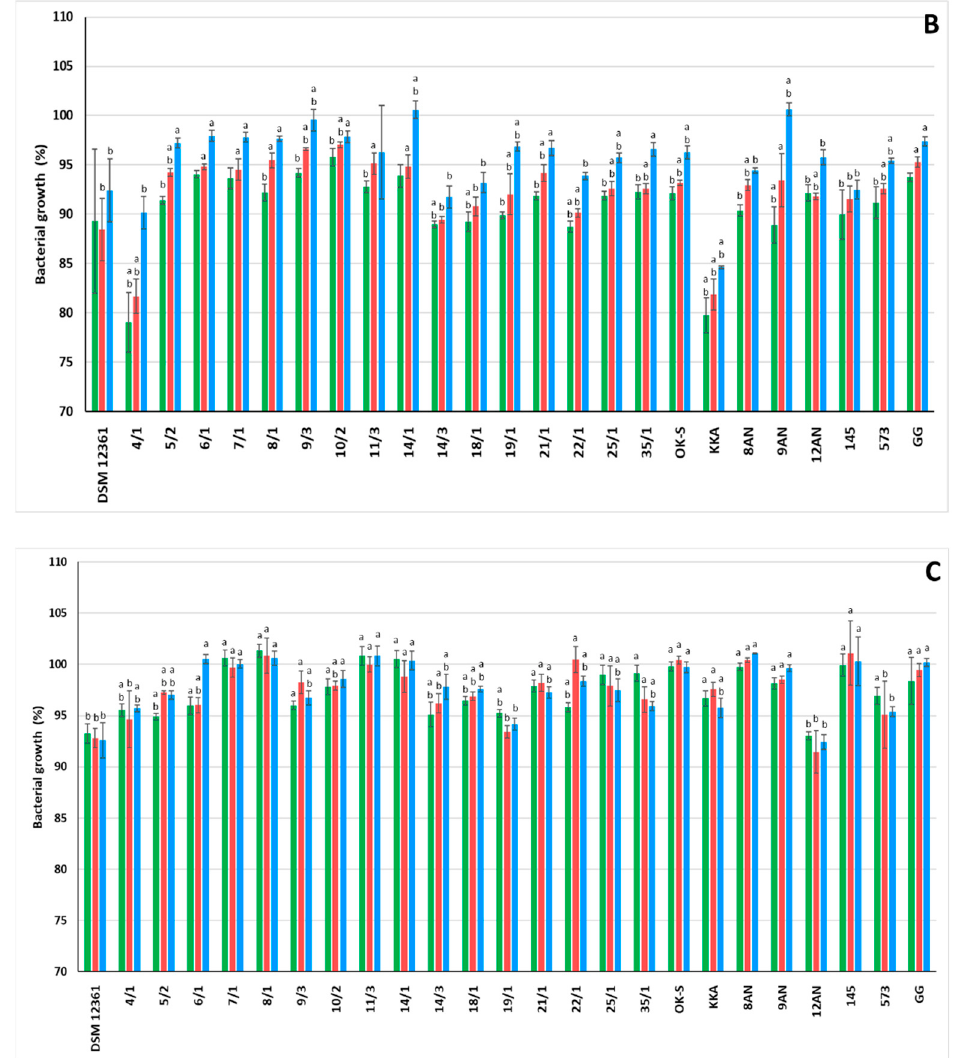
Figure 1. Effect of chlorpyrifos ( A ), coumaphos ( B ), and imidacloprid ( C ) on the growth of lactic acid bacteria strains during 48 h incubation, as evaluated with microtitration assay. Bars: green—20 μ g/mL; red—100 μ g/mL; blue—500 μ g/mL. Each data point represents the mean from four individual wells. Results are presented as mean ± standard deviation (SD). Statistically significant compared to a A. kunkeei DSM 12361 and b L. rhamnosus GG at p ≤ 0.05.